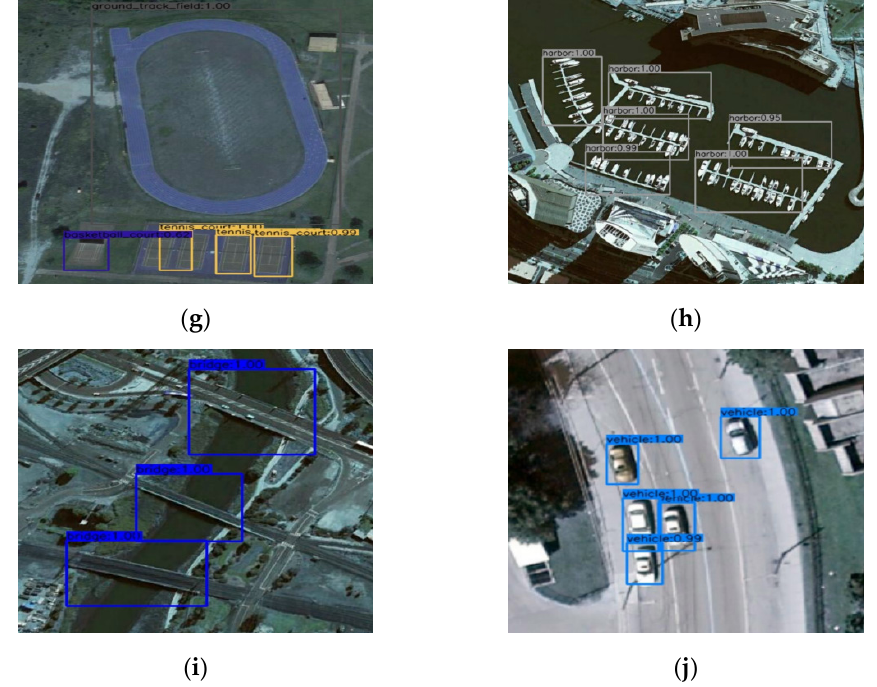
Figure 6. Object detection examples on NWPU-VHR-10 dataset. ( a ) Airplane; ( b )ship; ( c ) storage tank; ( d ) baseball diamond; ( e ) tennis court; ( f ) basketball court; ( g ) ground track field; ( h ) harbor; ( i ) bridge and( j ) vehicle.